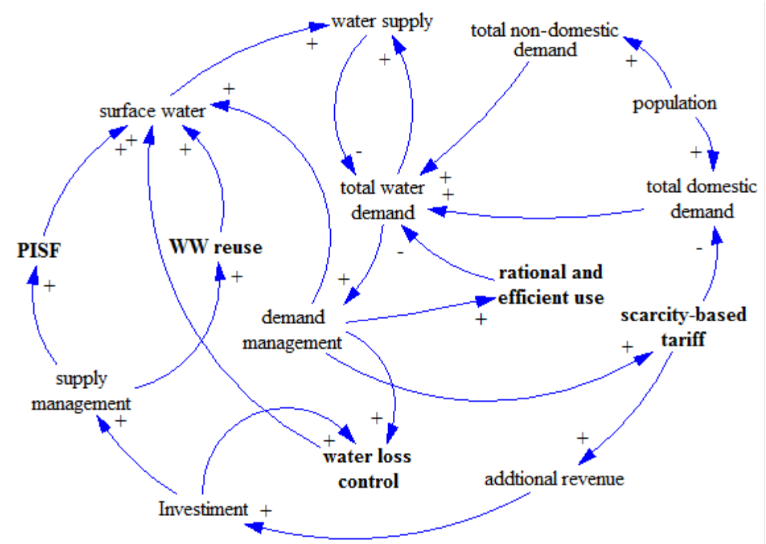
Figure 5. Causal loop diagram to represent the model “WSPB-SD”.